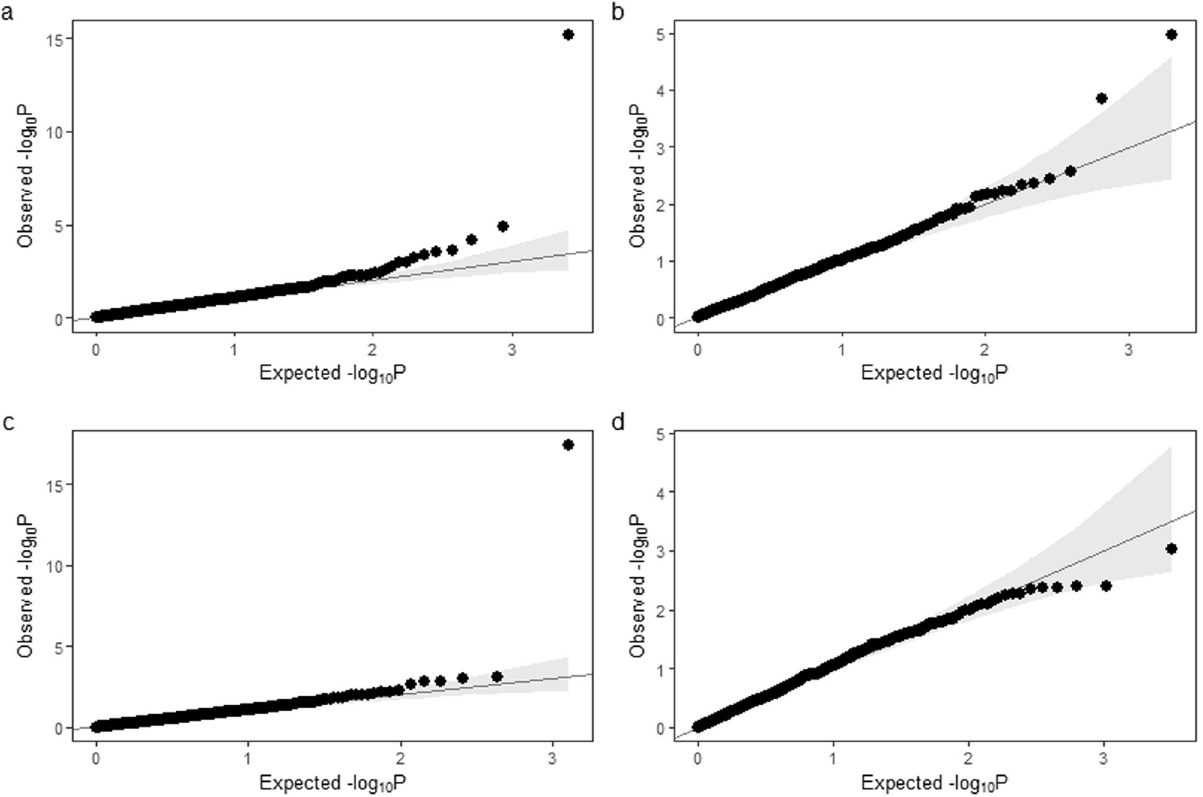
Fig. 2 QQ plots of association results. Quantile-quantile plots of P -values from association tests of deletion regions ( a ), duplication regions ( b ), gene burden analysis for deletions ( c ), and gene burden for duplications ( d